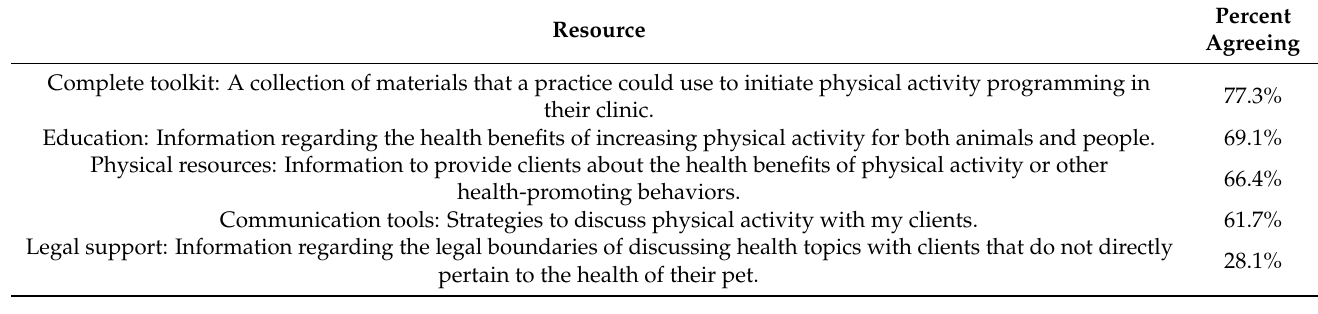
Resource their clinic.